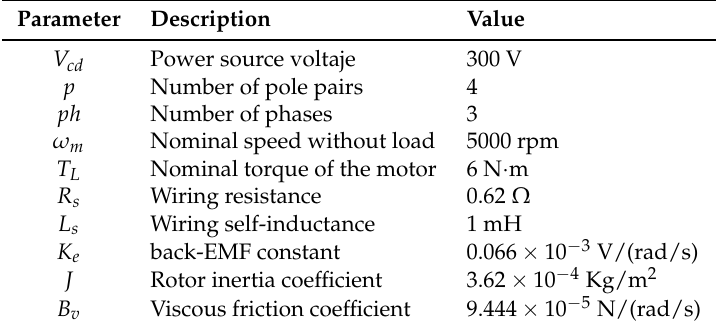
Table 3. Nominal operational parameters of the BLDC motor model used for simulation.